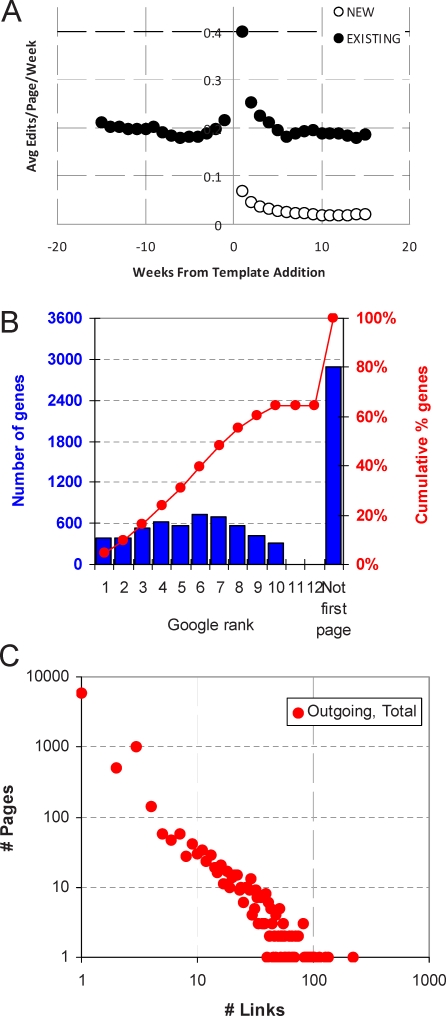
Analysis of Gene Wiki Impact(A) For the ~650 existing gene pages at Wikipedia that were amended with structured annotation, the cumulative rate of edits before and after addition was approximately the same. The rate of edits to the ~7,500 new gene pages was approximately 10-fold less than for the existing pages, though in total these edits accounted for approximately half of all edits to gene pages at Wikipedia. (B) When searching by gene symbol, Wikipedia gene pages are highly ranked by the Google search engine. Approximately 66% of all gene pages are found on the first page of search results. (C) The gene wiki can be analyzed in a network representation, where hyperlinks to other Wikipedia pages constitute network edges. Analysis of the network topology shows that connectivity follows a power law, indicative of a scale-free network.